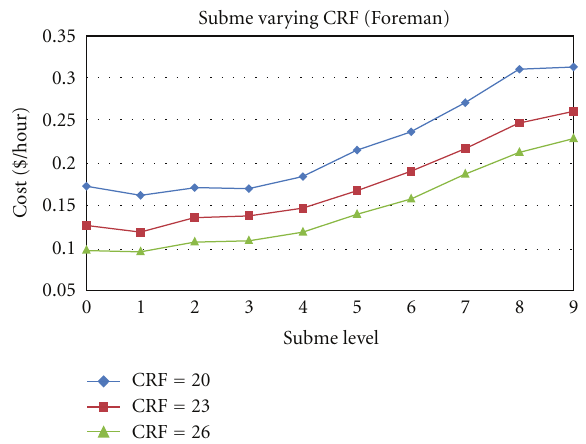
Figure 10: Averaged encoding cost for all videos.